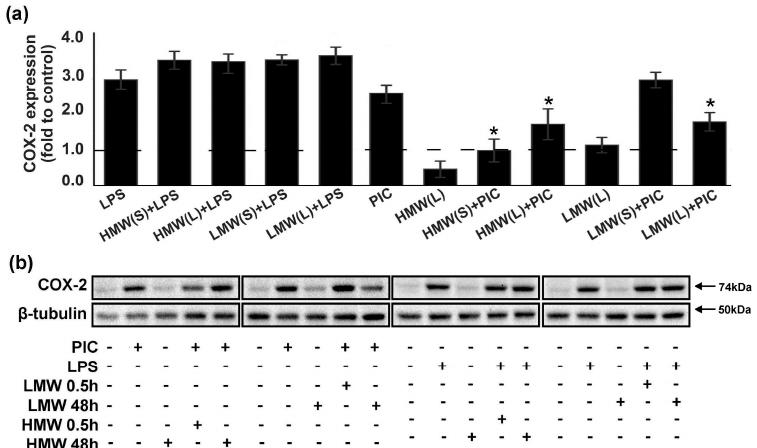
Figure 4. Effects of low molecular weight (LMW) and high molecular weight (HMW) hyaluronic acid (HA) on the expression of COX-2 upon stimulation with TLR3 and TLR4 agonists. ( a , b ) Astrocytes were pretreated for 0.5 or 48 h with HMW (10, 100 or 450 µg/mL) and (10, 100 or 450 µg/mL) alone or in combination with LPS (100 ng/mL) or PIC (10 µg/mL) for 4 h. COX-2 protein levels were evaluated by western blotting and normalized to the loading control β -tubulin. ( b ) The example is representative for three independent experiments. Values represent the mean ± SEM from three independent experiments performed in triplicate. * p < 0.05, compared with the stimulated cells (PIC or LPS).